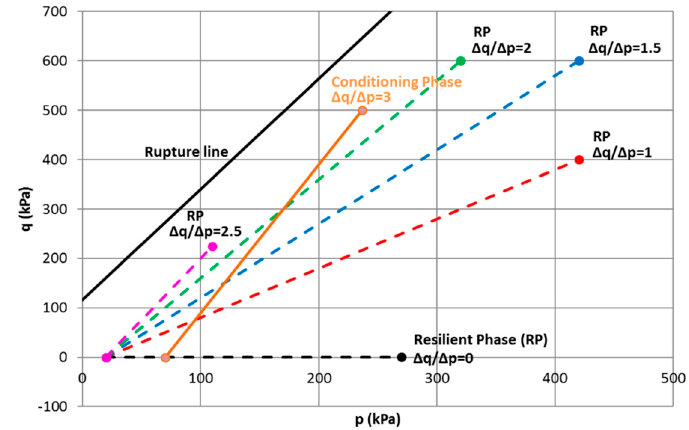
Figure 10. The principle of RLTT.